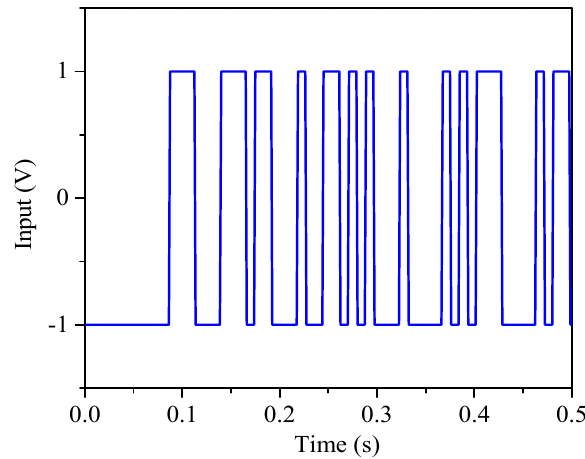
Figure 4. Inputs of the motor during the identification simulation.